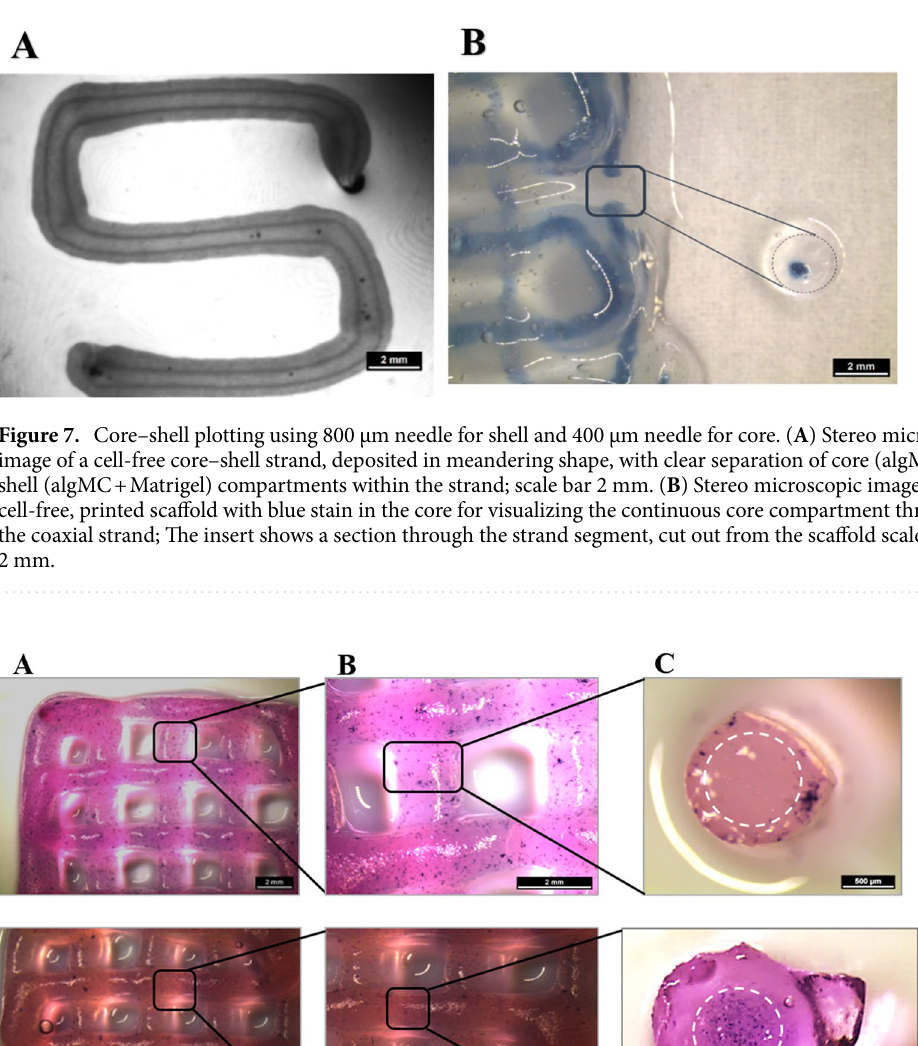
material (Fig. 8B). Scaffolds printed and crosslinked were mechanically robust also in presence of the cells while the strands maintained their cylindrical shape, defined coaxial structure and open macropores of the scaffolds over the whole culture period of 14 days. MTT assay, performed after 7 days of culture, indicated metabolically active cells in their respective compartments, stained by a violet color (Fig. 8). Simultaneous embedding of HepG2 and NIH 3T3 cells in core–shell strand scaffolds. In order to visualize both cell types after simultaneous bioprinting, first co-culture experiments were conducted with pre-labeled cells: DiD-labeled hepatocytes (red) were encapsulated in shell compartment consisting of algMC + Matrigel while DiI-labeled fibroblasts (cyan) were encapsulated in the core consisting of algMC. These scaffolds were then compared to monoculture scaffolds which had DiD-labeled hepatocytes in shell only with no cells in the core. Figure 9 clearly illustrates the distribution of cells along the whole strand in HepG2/NIH 3T3 co-culture (Fig. 9A) vs. HepG2 monoculture (Fig. 9B). By staining the core–shell strand scaffolds with Calcein AM, the viability of both cell types in the co-culture was proven—for better visualization, channels of calcein (green) and DiI (cyan, indicating the fibroblasts in the core) were merged in Fig. 9C.